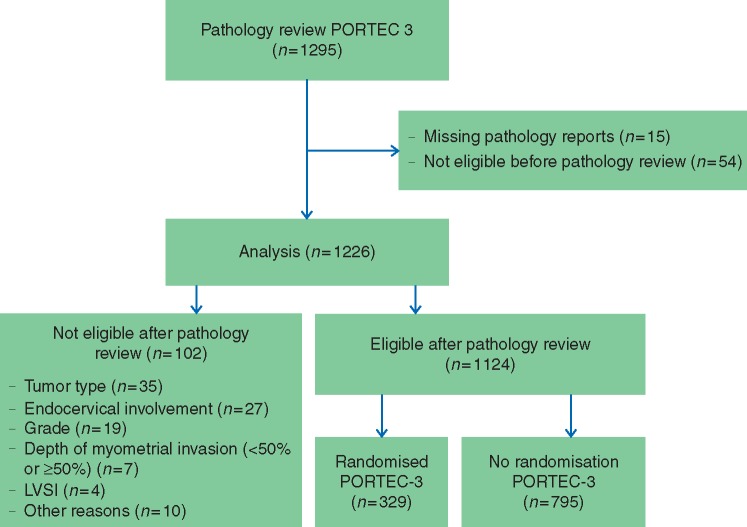
CONSORT diagram.